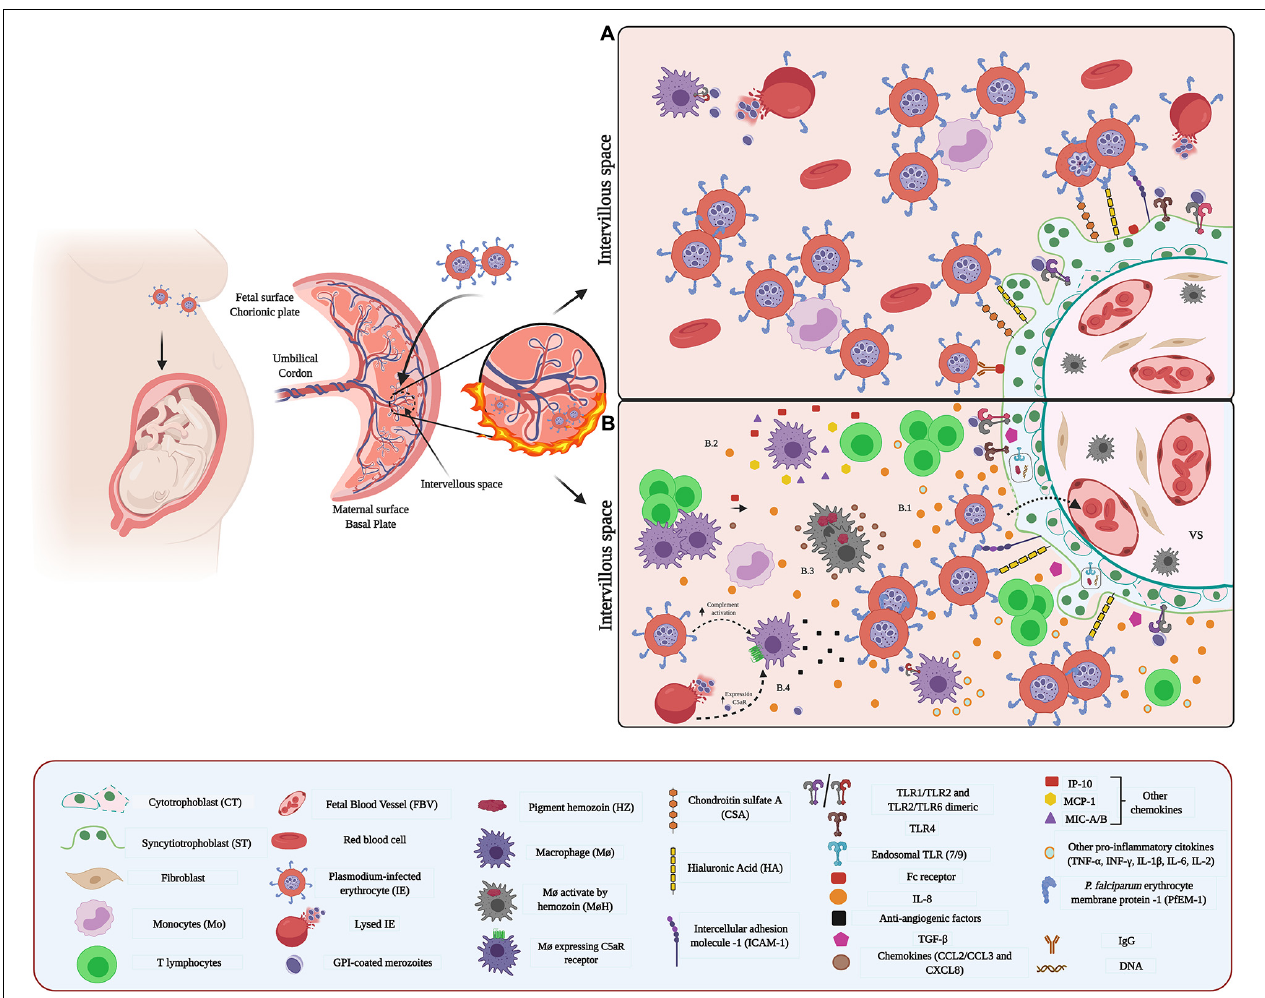
FIGURE 1 | Host–pathogen interaction between Plasmodium and placenta: (A) Adhesion and sequestration of parasite-IEs. IEs express parasite-derived proteins on their surface. For example, the PfEMP1 protein family is highly expressed in placental IEs and acts as a surface antigen and ligand for their adhesion and sequestration. PfEMP1 selectively binds to specific placental receptors such as CSA. Other receptor molecules such as HI and ICAM-1, expressed in ST, participate as key molecules in the adhesion process. (B) Microenvironment and inflammatory response (B.1,B.2) Inflammation in the IVS is attributed to chemokines and cytokines secreted by maternal Mo, T cells, and ST. (B.3) Parasite’s hemozoin induces activation of M (cid:56) , and subsequent release of chemokines. (B.4) Schizonts activate C5 and rupture releasing parasite components containing GPI that induce expression of C5aR and activate M (cid:56)